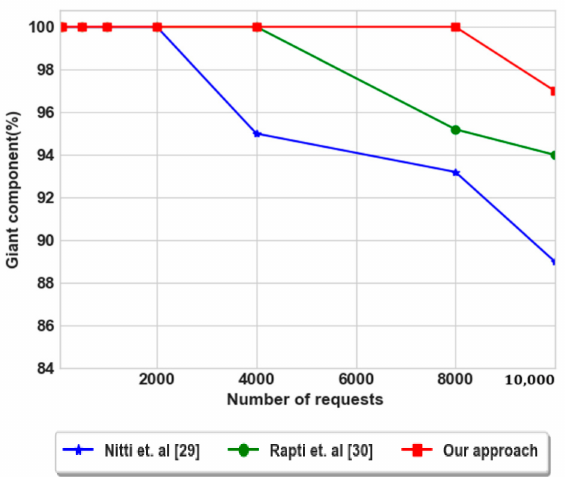
Figure 14. Giant component of social network during service